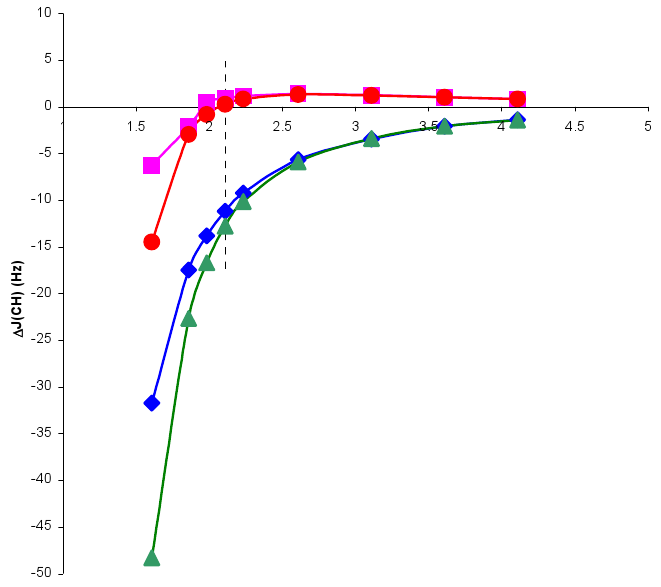
complex, ∆ J CG and ∆ J EG 2